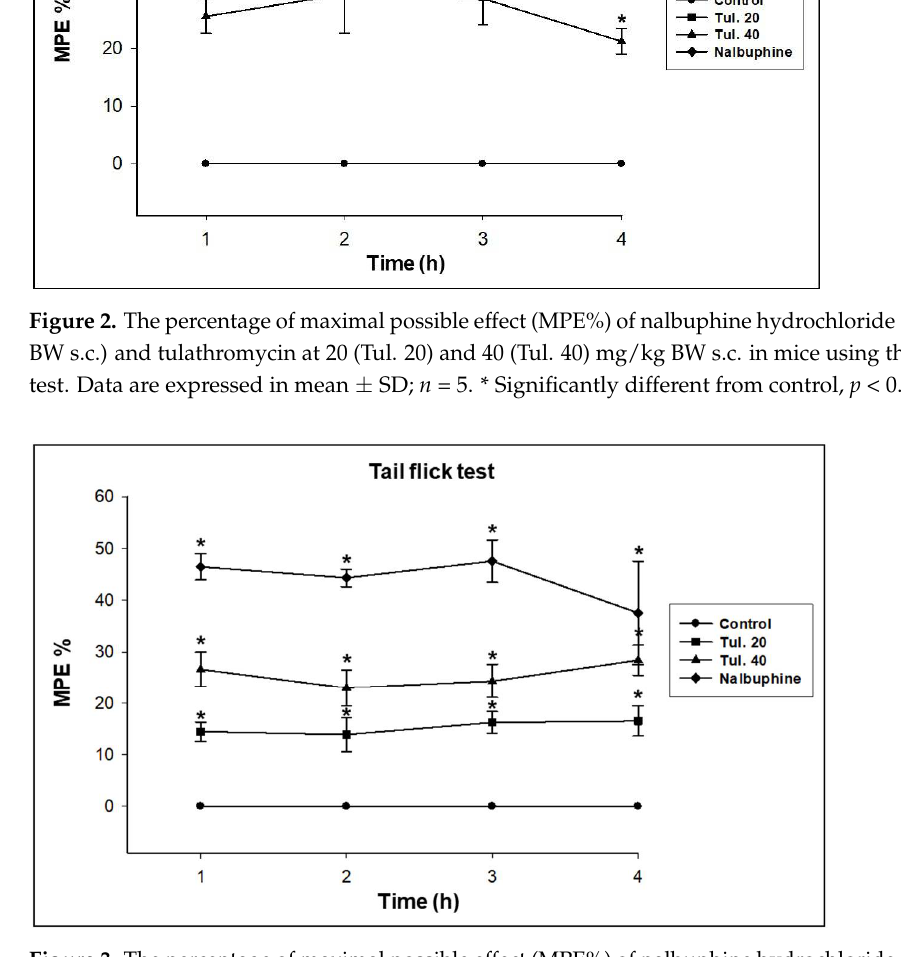
Figure 3. The percentage of maximal possible effect (MPE%) of nalbuphine hydrochloride (2.2 mg/kg BW s.c.) and tulathromycin at 20 (Tul. 20) and 40 (Tul. 40) mg/kg BW s.c. in mice using the tail-flick test. Data are expressed in mean ± SD; n = 5. * Significantly different from control, p < 0.05.